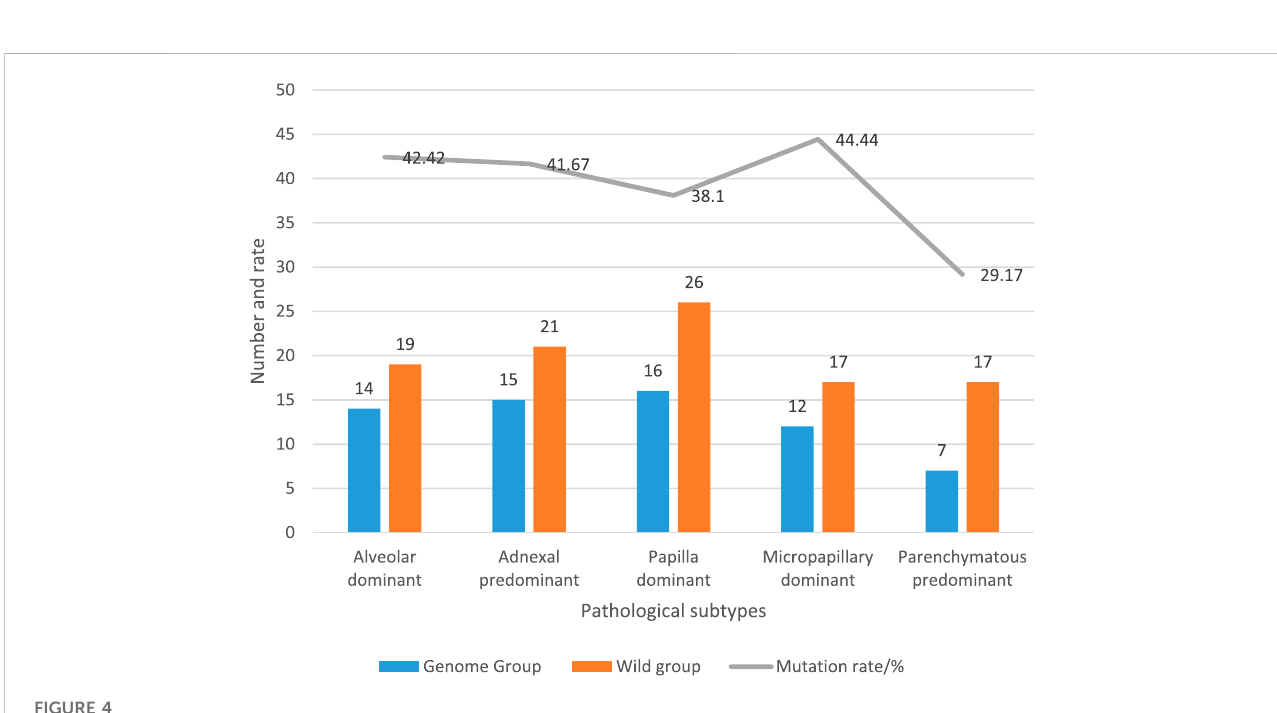
FIGURE 4 Pathological subtypes and EGFR mutation status in LUAD